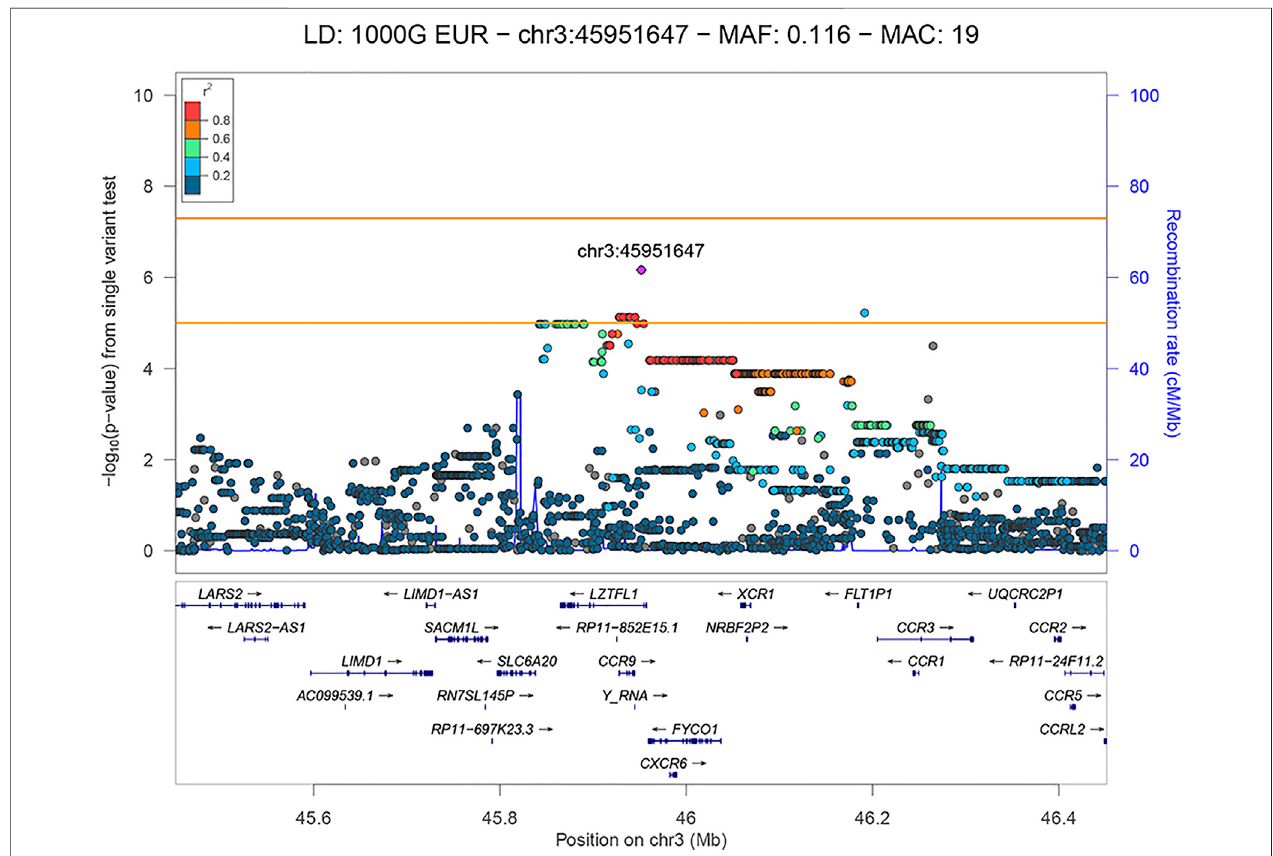
FIGURE3| LocusZoomplotshowingtheregionalassociationof3p21.31withCOVID-19severity(severeversusmildpatientgroupcomparison),withrs35280891 as the lead variant. Variants in linkage disequilibrium with rs35280891 are shown in color gradient indicating r 2 levels (hg19, 1KGP, Phase 3 — November 2014,